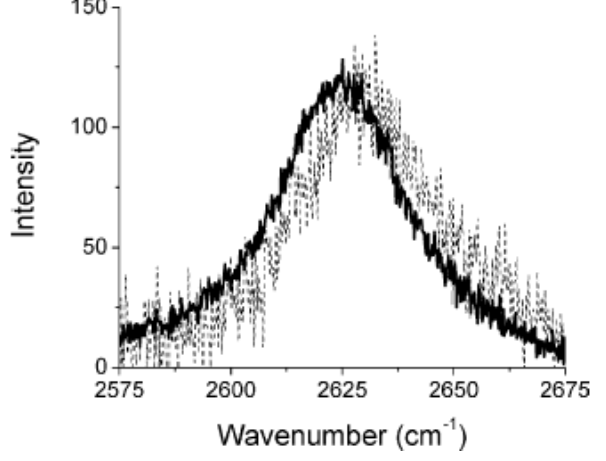
Figure 11. The Raman spectra of D*-mode in PP-1 wt % SWCNTs composite with no strain (dashed line) and with 2% strain (solid line). Reproduced with permission from ref. [27].